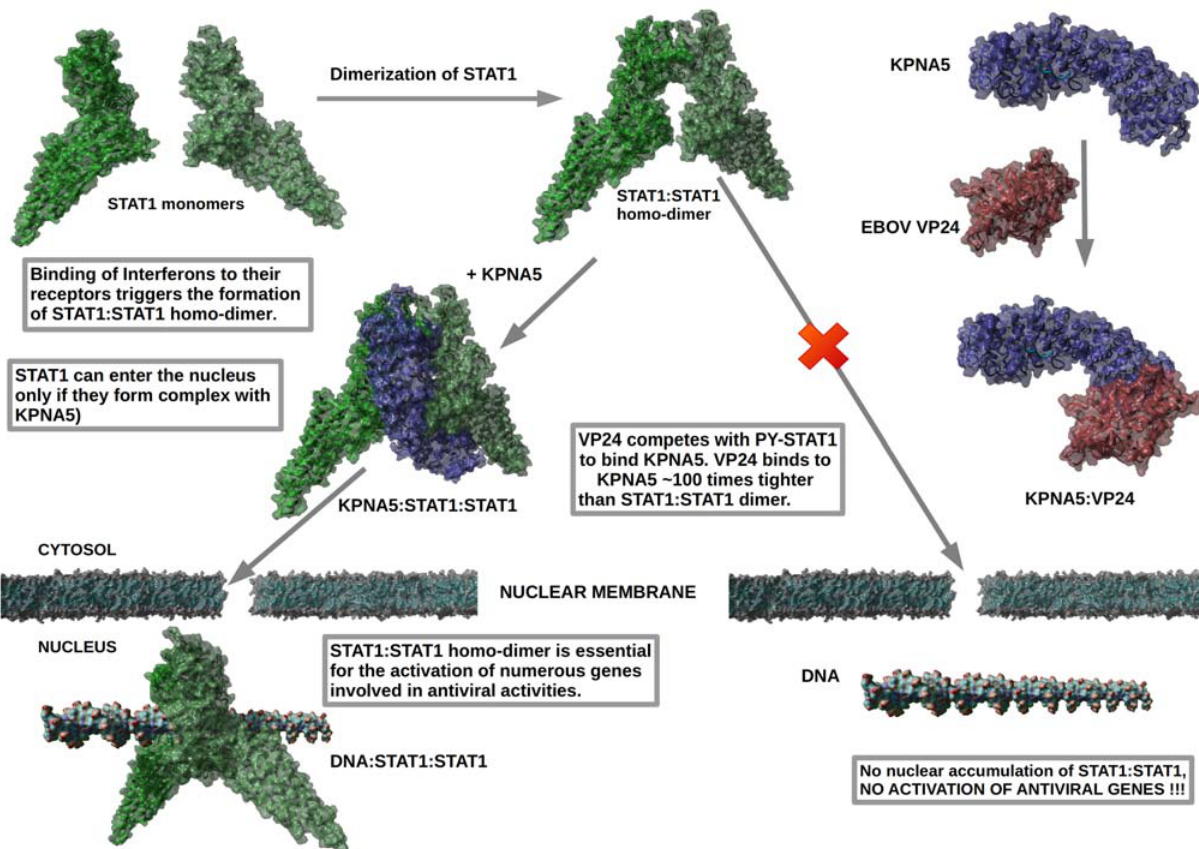
Figure 1 Transfer of STAT1 homo-dimer to the nucleus in the case of common (left) and EBOV (right) infection. VP24 acts as an interferon anta- gonist by blocking the interaction between KPNA5 and STAT1:STAT1 homo-dimer which is required for the translocation of STAT1:STAT1 across the nucleus